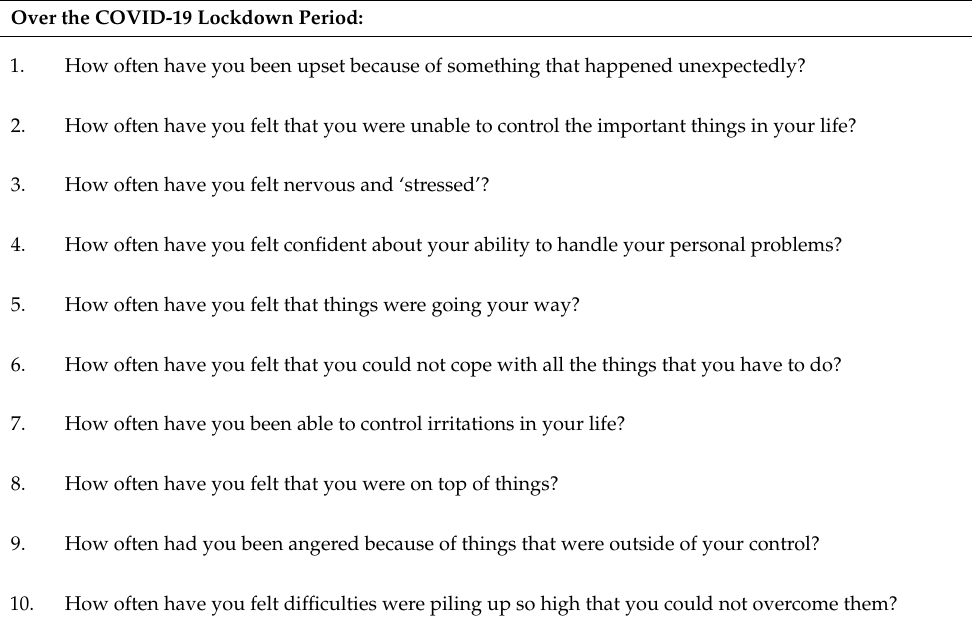
Table 1. Adapted Questioner from Short Form of the Perceived Stress Scale